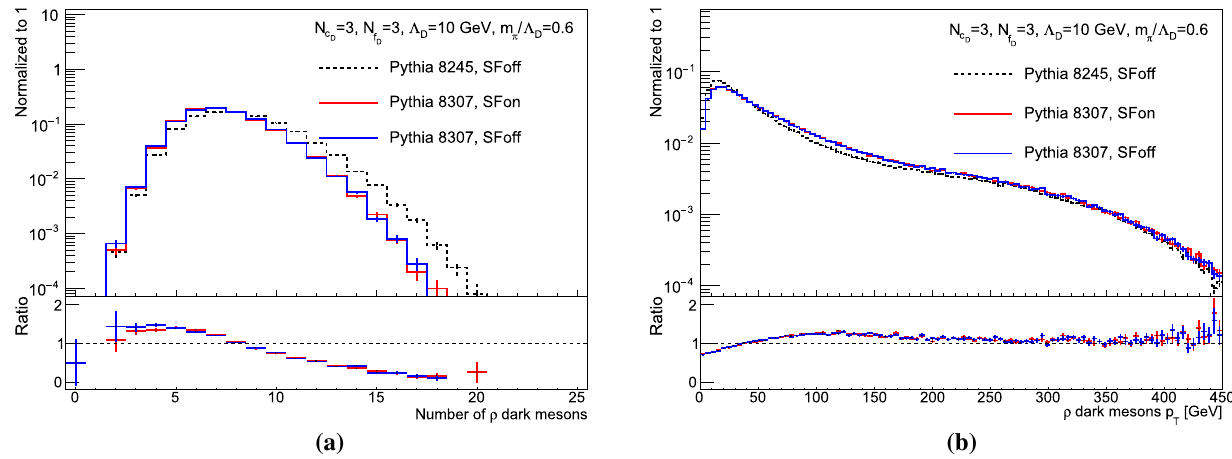
ρ D mesons, b D meson p T distribution. The bottom panels show the ratio of